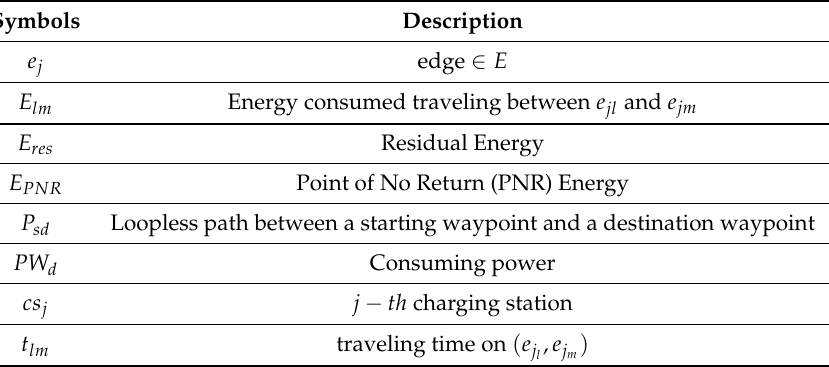
Table 4. Drone behavior model: used